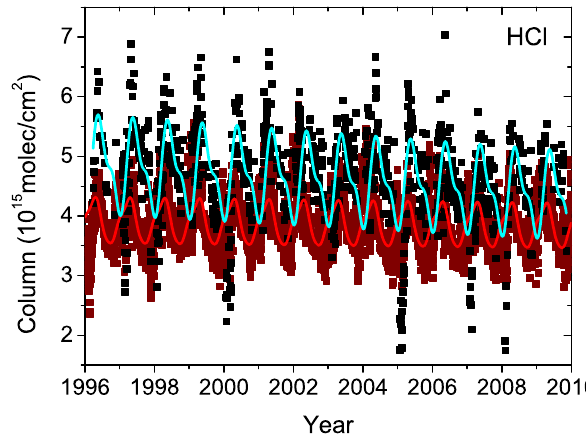
Fig. 4. Time series of FTIR measurements (black squares) and KASIMA model data (dark red squares) of HCl above Kiruna from 1996 to 2009 and the least squares fits of Eq. (1) to the measure- ments (cyan line) and model data (red line).